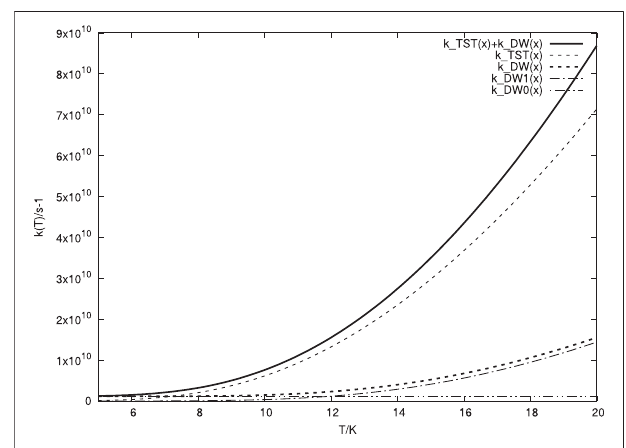
FIGURE 1 | Thermal rate constants for H atom transitions between wells. “ k-TST (x) ” is the TST rate constant. “ k-DW(x) ” is the tunnelling rate constant for the double well with lattice interaction. “ k-DW0 (x) ” is the contribution to “ k-DW (x) ” from the lowest pair of eigenstates, while “ k- DW1(x) ” isthe contribution fromthe nextpair ofeigenstates. “ k-TST(x)+k-DW (x) ” is the total rate constant obtained as a sum of “ k-TST (x) ” and “ k-DW (x) ” .